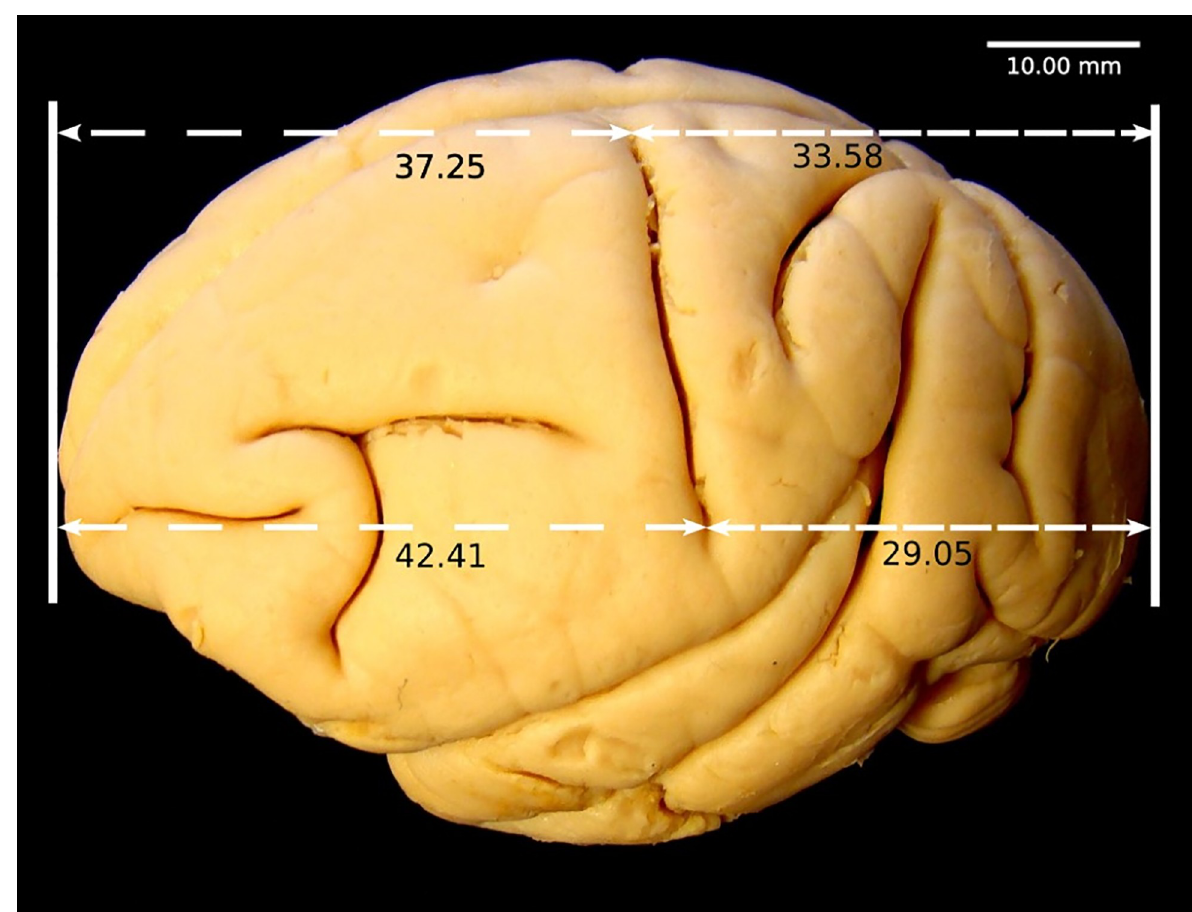
Fig 7. Photograph of the left convex aspect of the Sapajus libidinosus brain indicating the distance from the superior and inferior extremities of the central sulcus to the frontal and occipital poles. These measurements indicate the degree of inclination of the central sulcus.